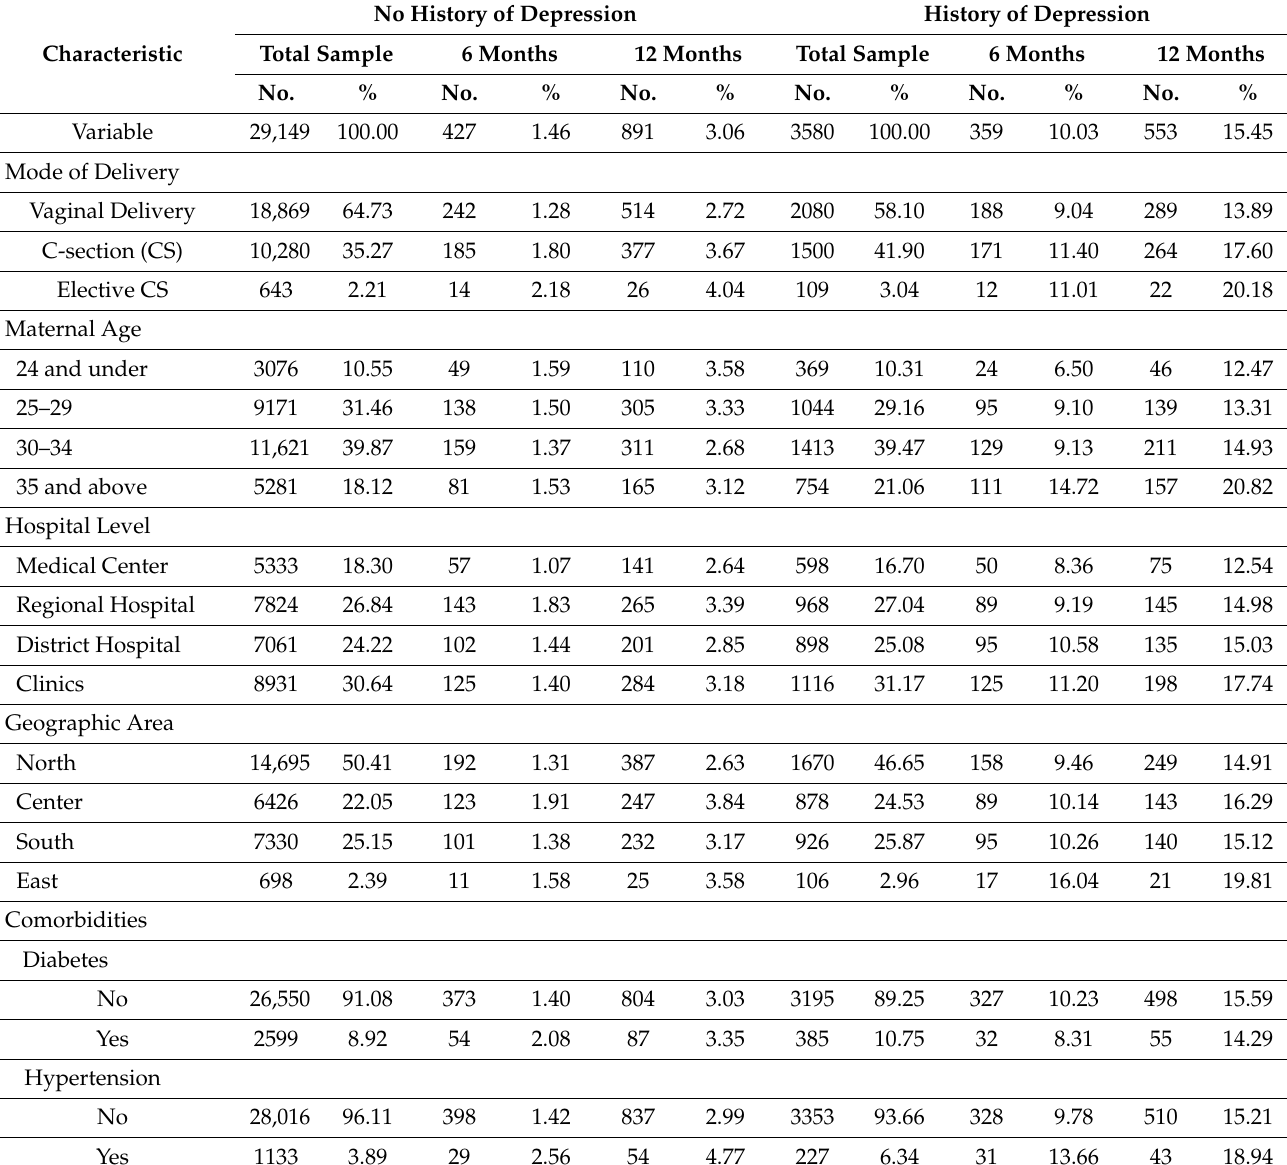
Table 1. Characteristic of the sample for women with and without a history of